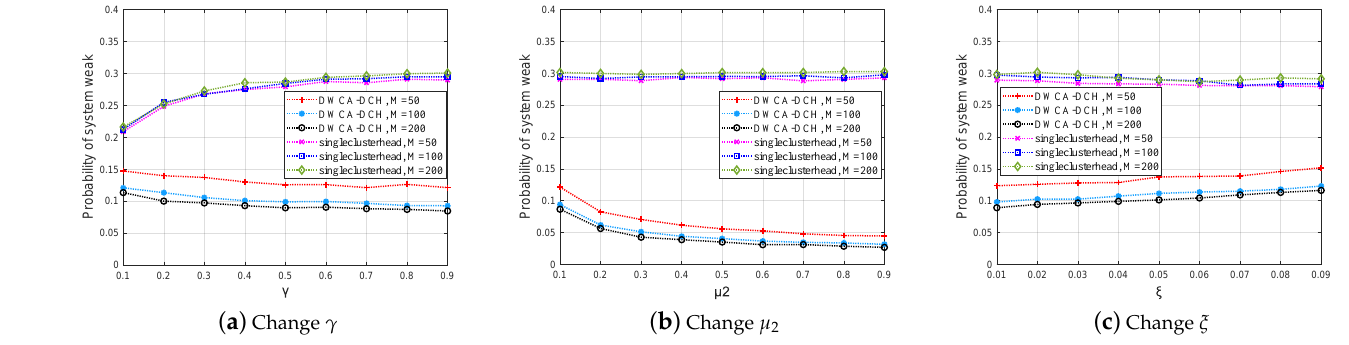
Figure 8. The variation trend of system weak probability with different parameters. Figure 9a–c shows the variation trend of system unavailable probability with different parameters. It can be seen that the unavailable probability of the dual cluster head algorithm is much lower than that of the single cluster head algorithm. With the increase in the number of UAV nodes, P unav gradually decreases in DWCA-DCH. P unav decreases as γ increases. When µ 2 is increased, P unav basically keeps steady. When ξ increases, P unav increases significantly, while the curve of the dual cluster head is flatter, indicating that the proposed DWCA-DCH has better performance in improving system stability. Therefore, in the actual deployment, in order to reduce the probability of system unavailable, the fault maintaining and charging rate should be increased, and reasonable measures should be taken to reduce the fault rate of UAV.